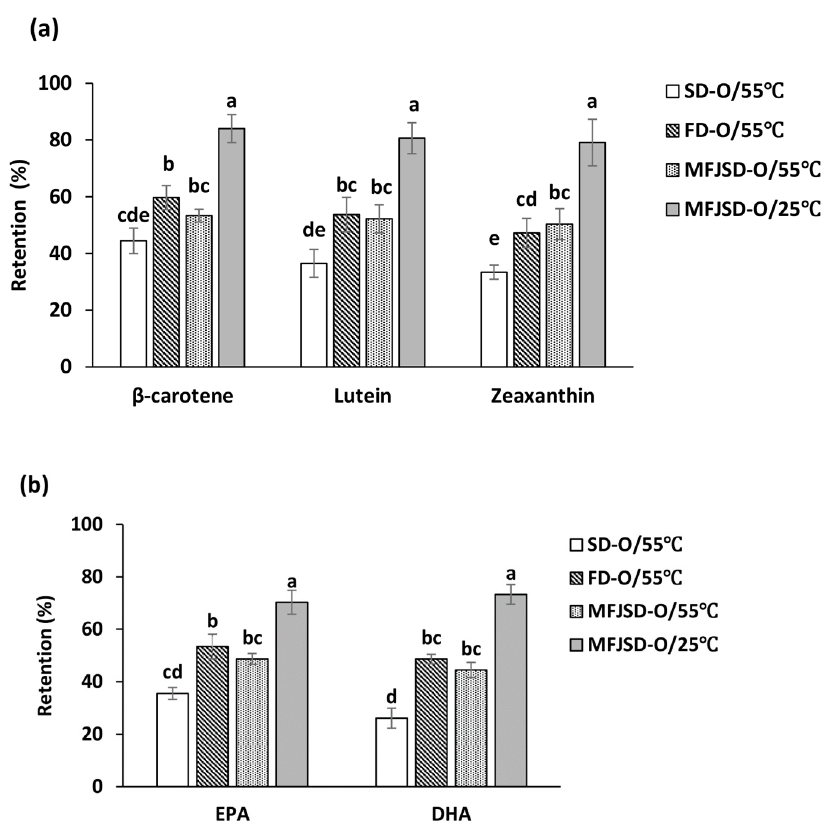
Figure 4. Retentions of ( a ) β -carotene, lutein, zeaxanthin and ( b ) EPA, DHA after a 4-week period at 25 ◦ C and 55 ◦ C. SD-O: microcapsules produced by two-fluid nozzle spray drying, using OSA only as wall material; FD-O: microcapsules produced by freeze-drying, using OSA only as wall material; MFJSD-O: microcapsules produced by microfluidic-jet spray drying, using OSA only as wall material. WPI: whey protein isolate; OSA: octenylsuccinic anhydride modified starch. Different lowercase letters indicate significant differences at p < 0.05.